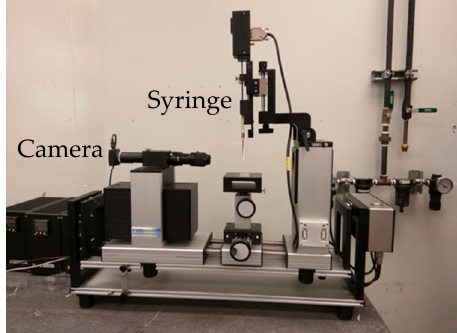
Figure 1. Setup for surface tension measurement .